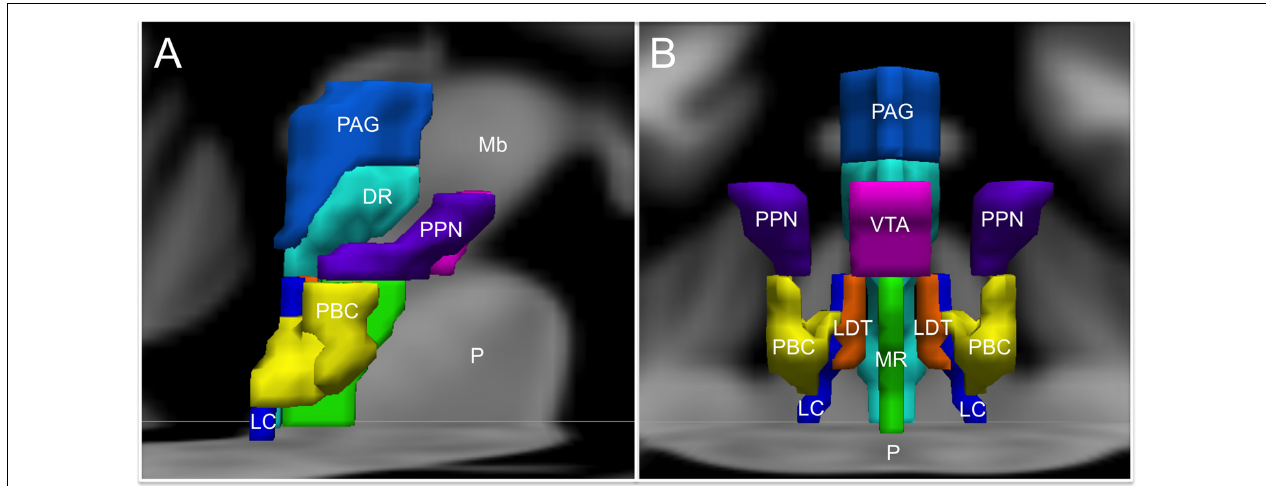
FIGURE 1 | Brainstem nuclei involved in human emotion. (A) Sagittal view and (B) Coronal view. DR, Dorsal Raphe; LC, Locus coeruleus; LDT, Laterodorsal tegmental nucleus; Mb, Midbrain; MR, Median raphe; P, Pons; PAG, Periaqueductal gray; PBC, Parabrachial nuclear complex; PPN, Pedunculopontine nucleus; VTA, Ventral tegmental area. The substantia nigra and the nucleus of the tractus solitarius are not shown to optimize visibility of the other structures.